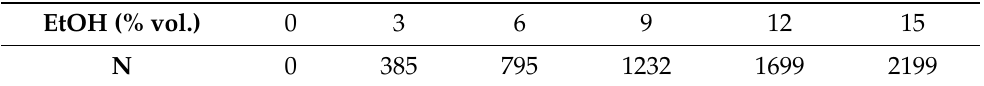
Table 1. Number of EtOH molecules ( N ) in simulation boxes composed of 4 × 10 4 water molecules and 200 CO 2 molecules for EtOH levels ranging from 0 to 15% vol. N values are computed at a reference temperature of 285